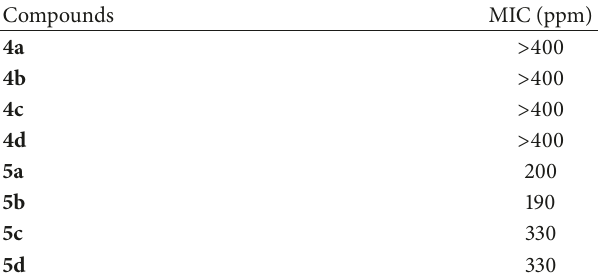
Table 1: MIC for 4a–d and 5a–d